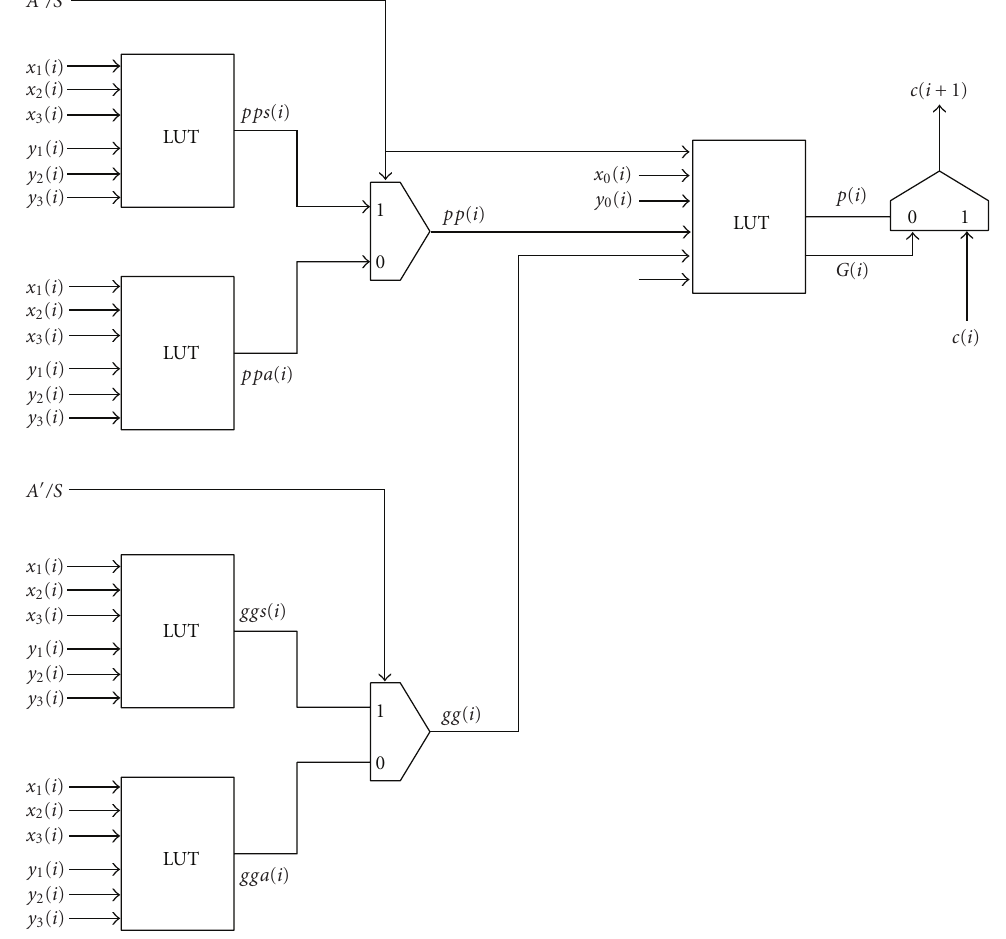
Figure 17: FPGA implementation of the carry-chain stage AS -II for BCD adder-subtractor.